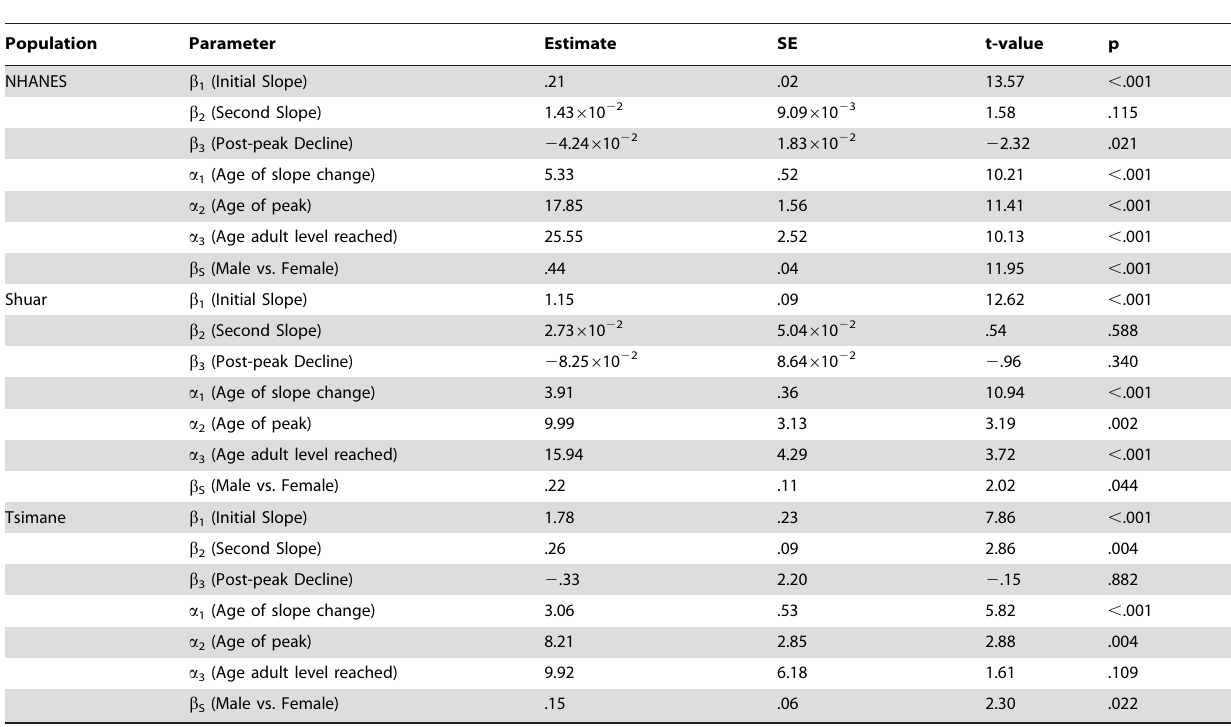
Table 2. Non-linear model parameters by